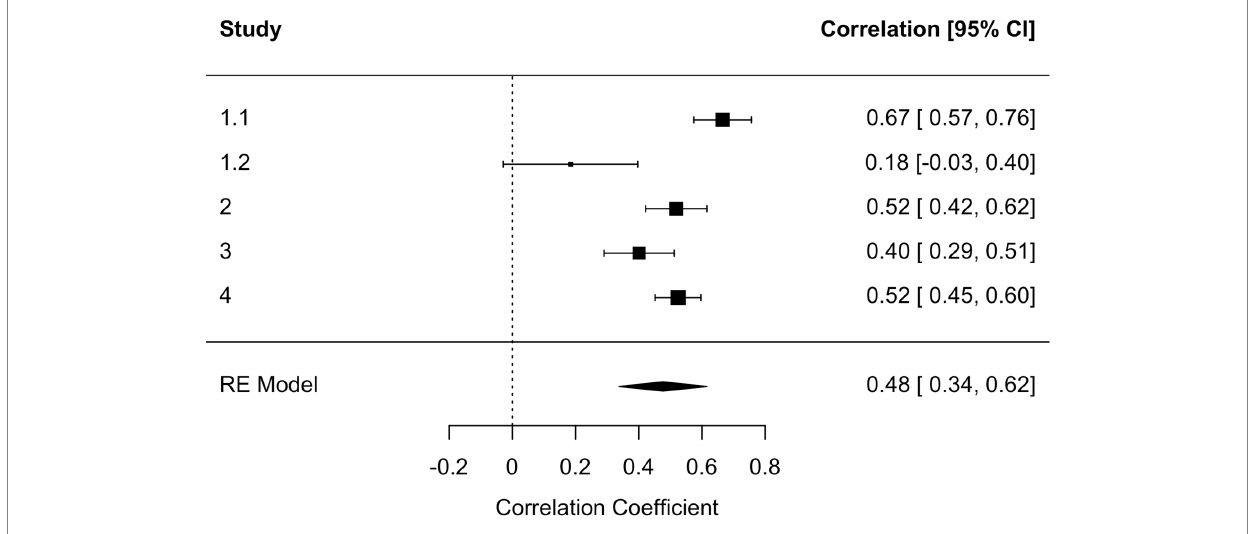
FIGURE 2 Forest plot of the random effects meta-analysis between kama muta and intentions across Studies 1 to 3. Q (4) = 23.66, p < 0.001, I 2 = 88.83 [64.73, 98.97].